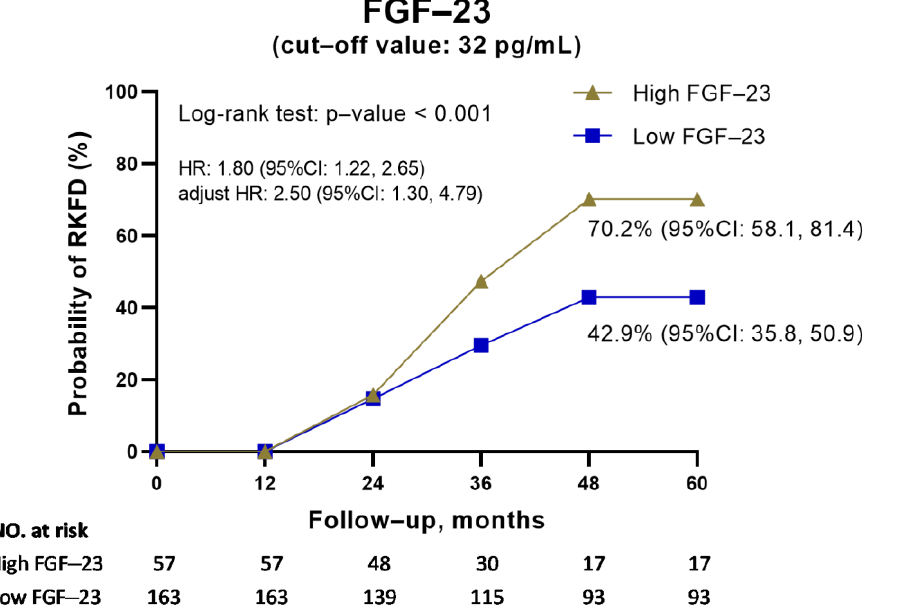
Figure 5. Kaplan–Meier estimation of the probability of the occurrence of RKFD stratified by Figure 5. Kaplan – Meier estimation of the probability of the occurrence of RKFD stratified by FGF- 23.